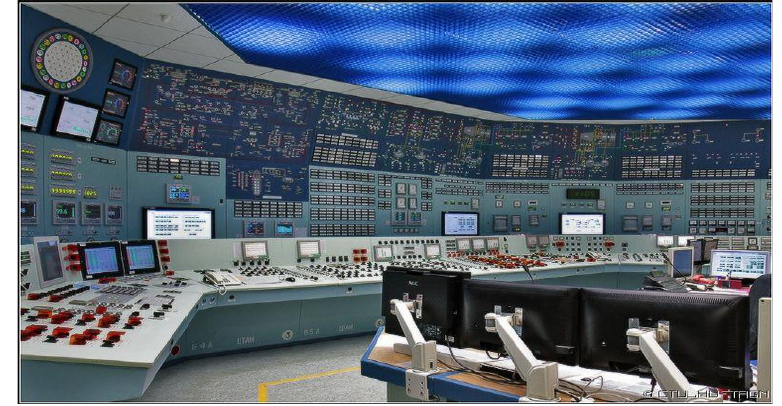
Figure 2. Control room in a nuclear